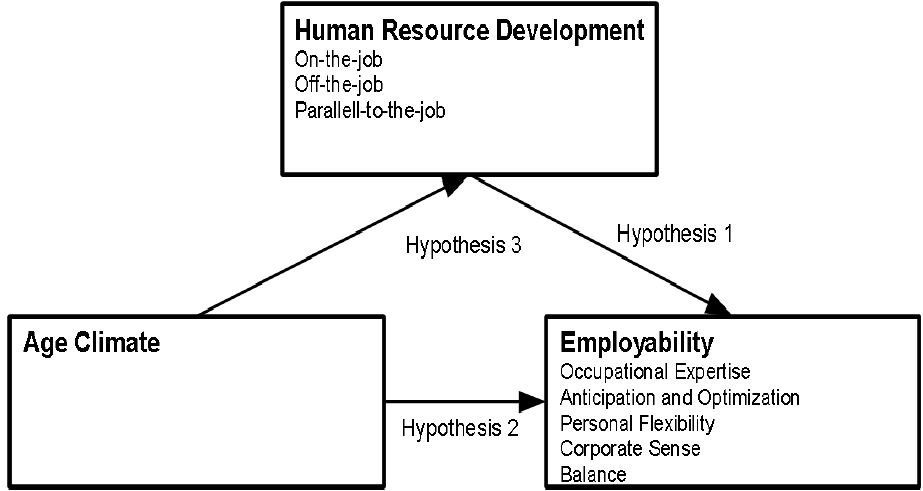
Figure 1. Research model (Source: Authors).